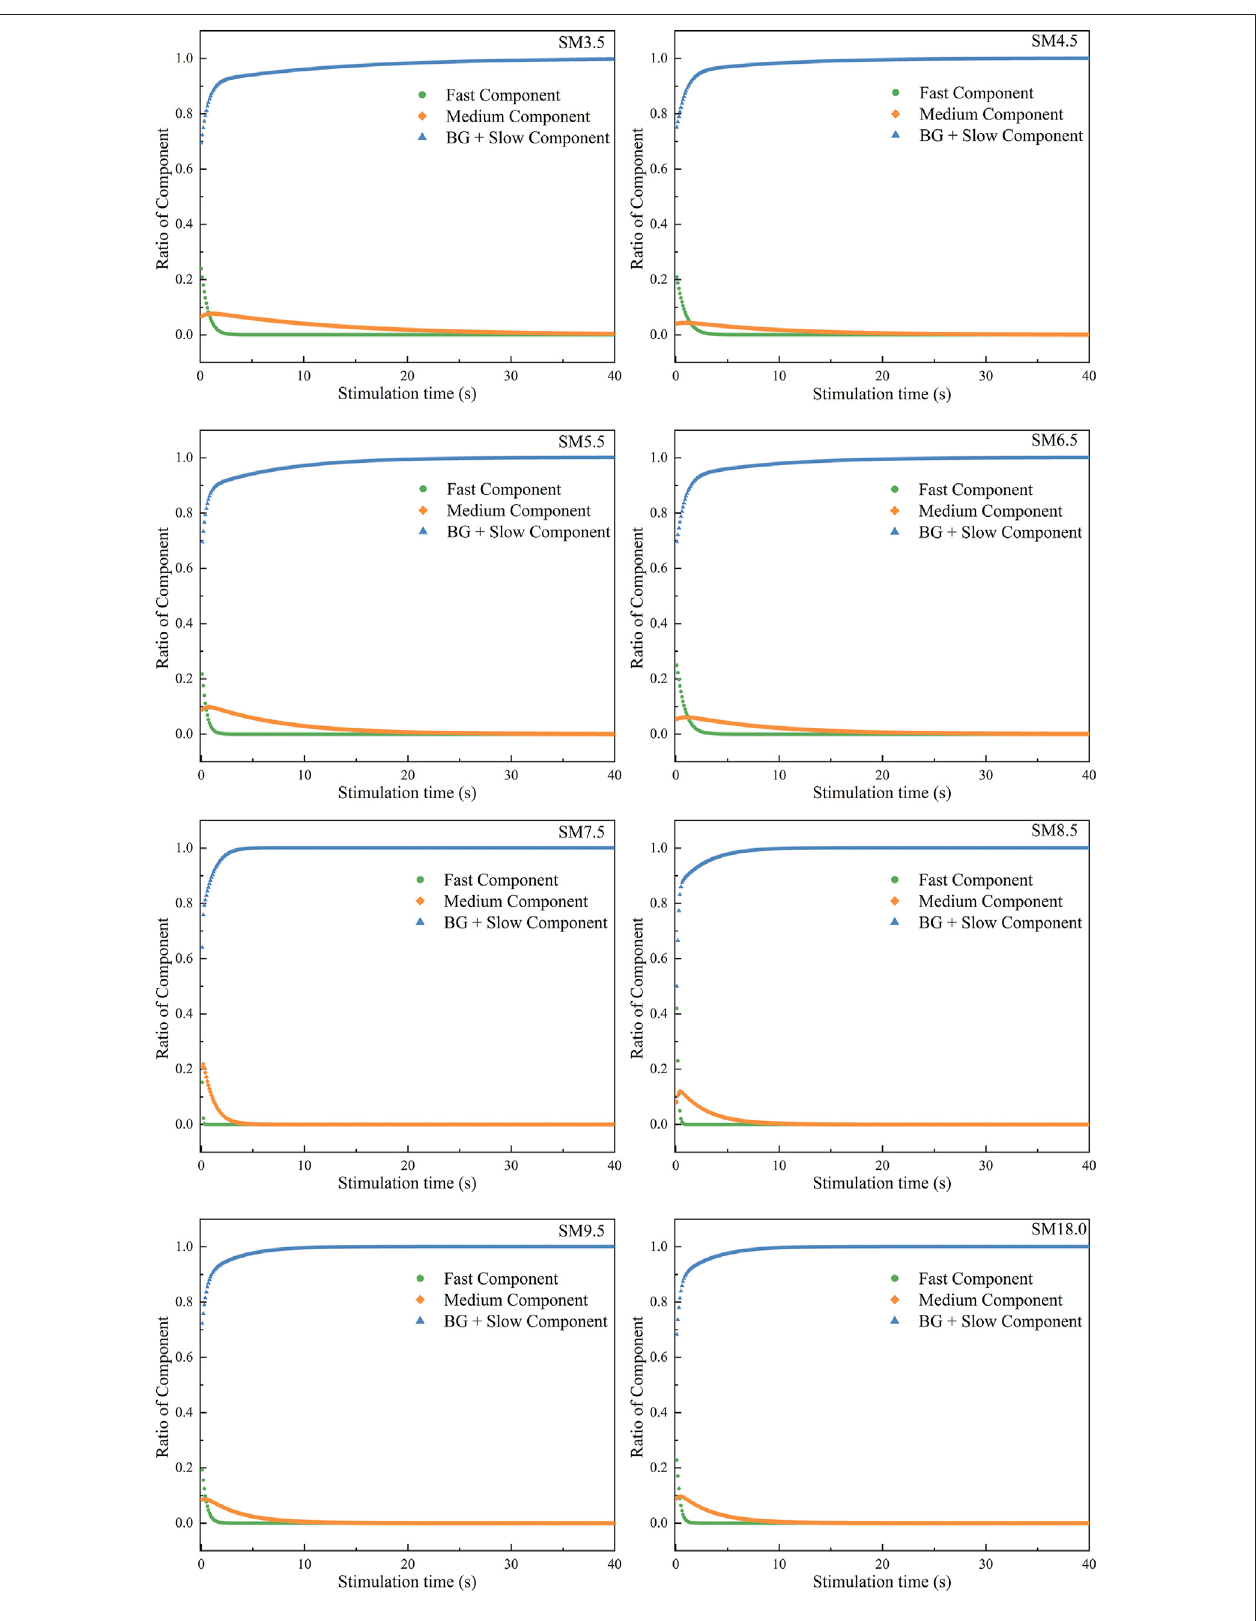
FIGURE 5 | The fast, medium and slow components variations with the stimulation time. For an apparent presentation, the fi rst 40 s of data were intercepted for plotting.